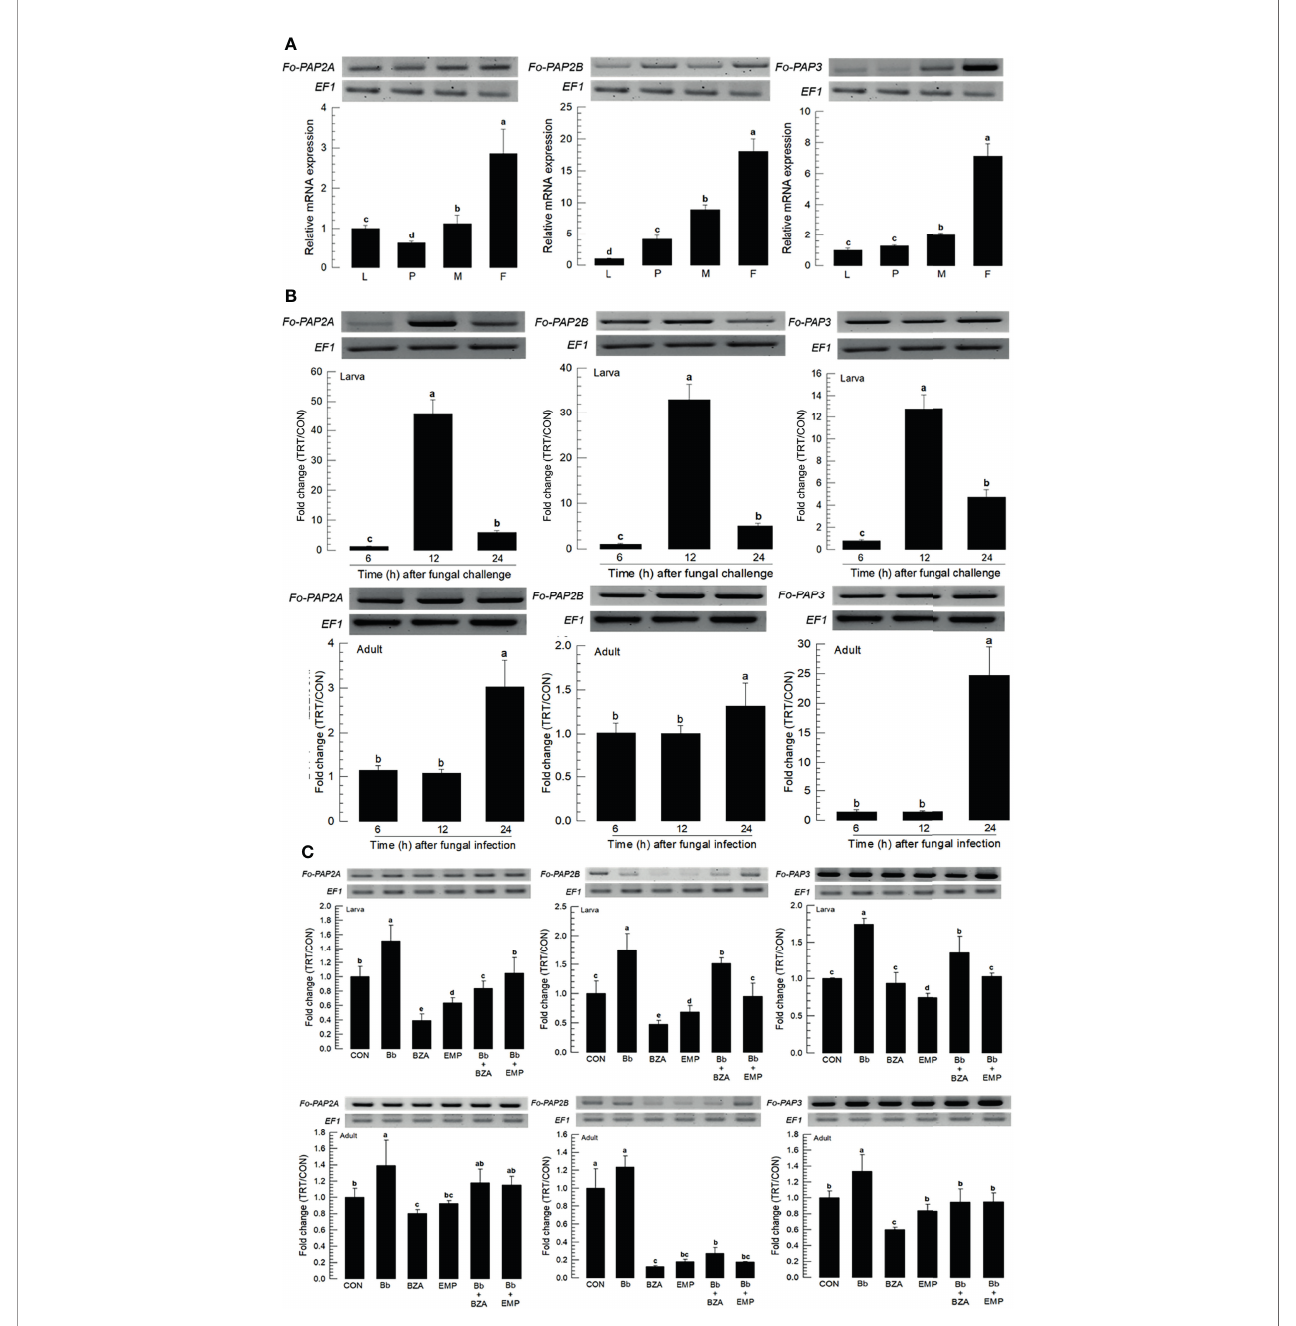
FIGURE 7 | Inducible expression of three prophenoloxidase-activating proteinases (PAPs) in F . occidentalis ( Fo-PAP ) named Fo-PAP2A , Fo-PAP2B , and Fo- PAP3 upon fungal challenge. (A) Expression levels of Fo-PAP in different developmental stages of larva ( ‘ L ’ ), pupa ( ‘ P ’ ), male ( ‘ M ’ ) and female ( ‘ F ’ ) adult. RNA samples were collected from the whole body extracts of larvae (~100), pupae (~100), or adults (~100) for each treatment. (B) Inducible expression of Fo-PAP in L2 larvae or adults upon a fungal challenge with B. bassiana (1×10 6 conidia/mL) at different time points. RNA samples were collected from the whole body extracts of larvae (~100) or adults (~100) for each treatment. (C) Inhibitory effect of EMP or BZA on the expression of Fo-PAP in larvae or adults. To check immunosuppressive activity, B. bassiana (1×10 5 conidia/mL) along with EMP (1,000 ppm) or BZA (1,000 ppm) were used as mentioned previously. RNA samples were collected from the whole body extracts of larvae (~100) or adults (~100) for each treatment after 24 h of post-infection. The expression of an endogenous gene, EF1 , con fi rms equal gel loading and integrity of the cDNA preparation. Each measurement was replicated three times. Fold changes are calculated by ratios of expression levels of immune-challenges ( ‘ TRT ’ ) over naïve ( ‘ CON ’ ) thrips. Different letters above standard deviation bars indicate signi fi cant differences among means at Type I error = 0.05 (LSD